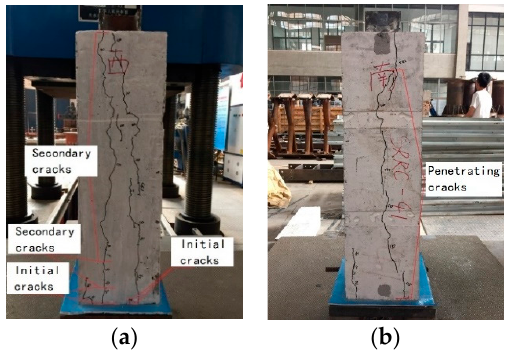
Figure 4. Splitting failure of SRRC-5: ( a ) web; ( b )